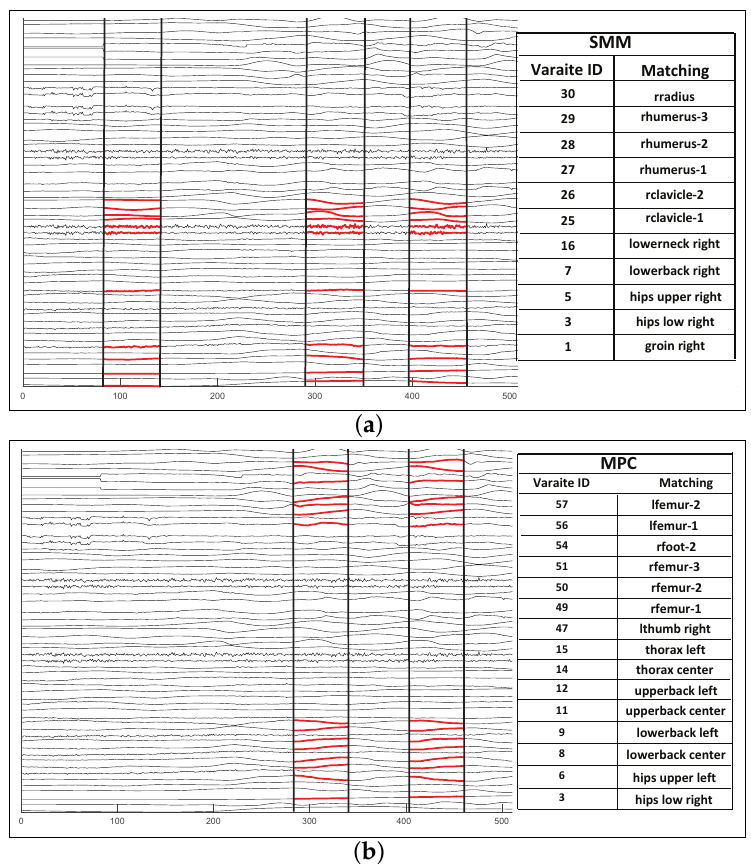
Figure 9. Sample motifs identified by the proposed SMM approach and a competitor (MPC [25]). The motifs extracted by SMM are contextually meaningful, whereas MPC’s motifs (obtained without considering the metadata associated with the time series) are noisy. ( a ) Sample SMM motif—note that the repeating pattern is detected on sensors at the same (right) side of the body. ( b ) Corresponding motif identified by a competitor—some sensors included in the motif include those that are irrelevant to the action; the motif also misses one recurring